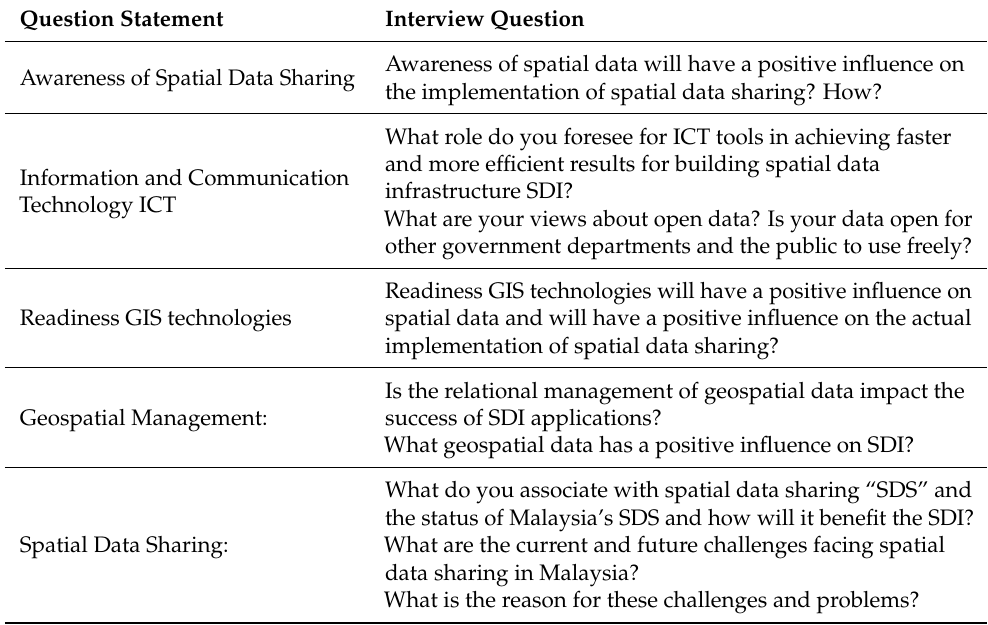
Table 2. In-depth interview field and